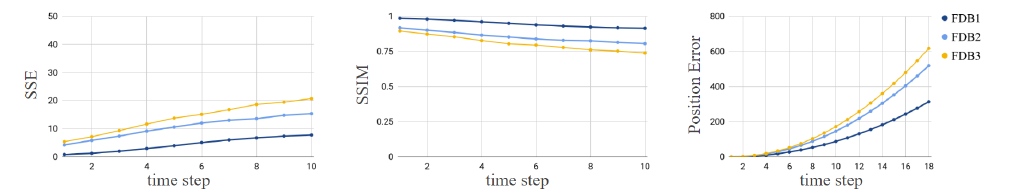
Figure 8. Errors for each prediction time step from FDB1 to